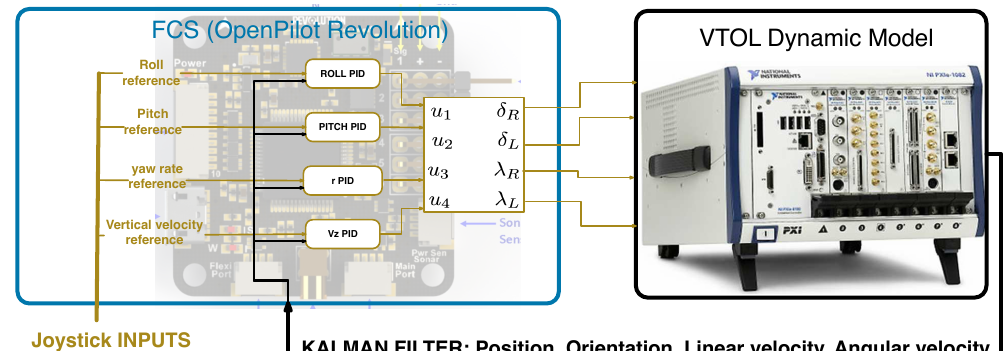
Figure 9. Hardware In the Loop platform